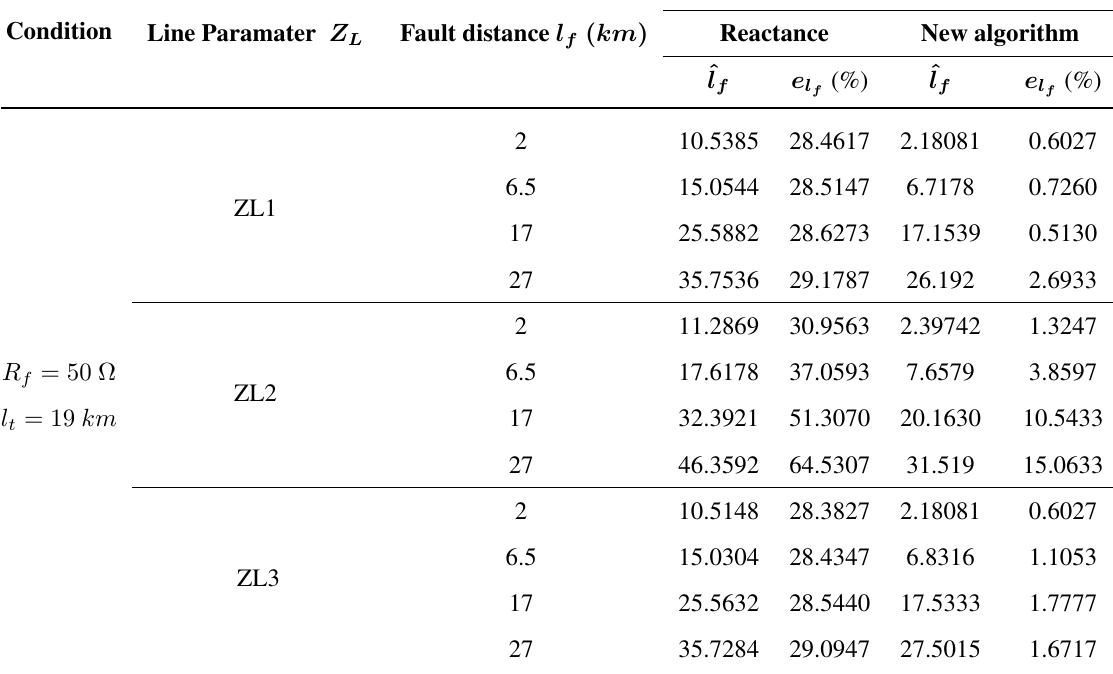
Table 6. The l calculation with different line f